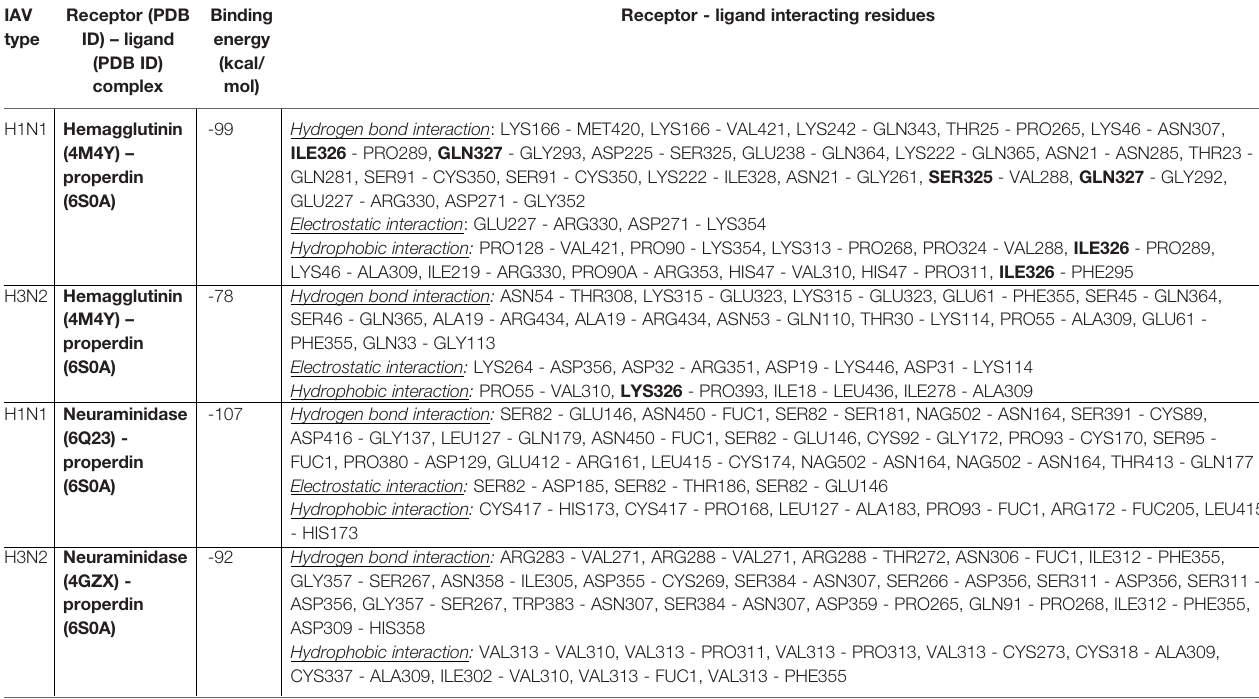
TABLE 3 | Binding energy of properdin with IAV receptors (HA and NA of H1N1 and H3N2) and their interacting residues from the lowest energy docked